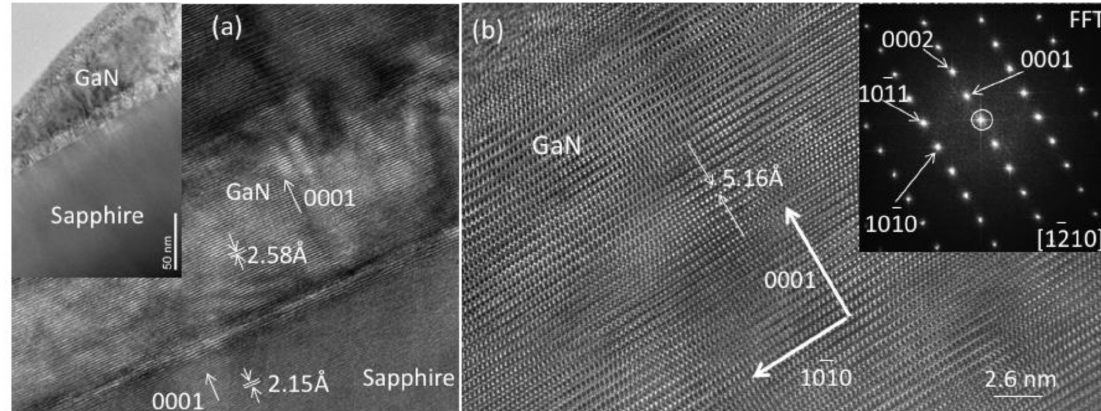
Figure 5. ( a ) TEM image showing GaN film on (0001) sapphire. ( b ) HRTEM image showing the lattice (0001) and (10-10) planes close to the [1-210] zone. The FFT from the HRTEM image is shown as an inset.